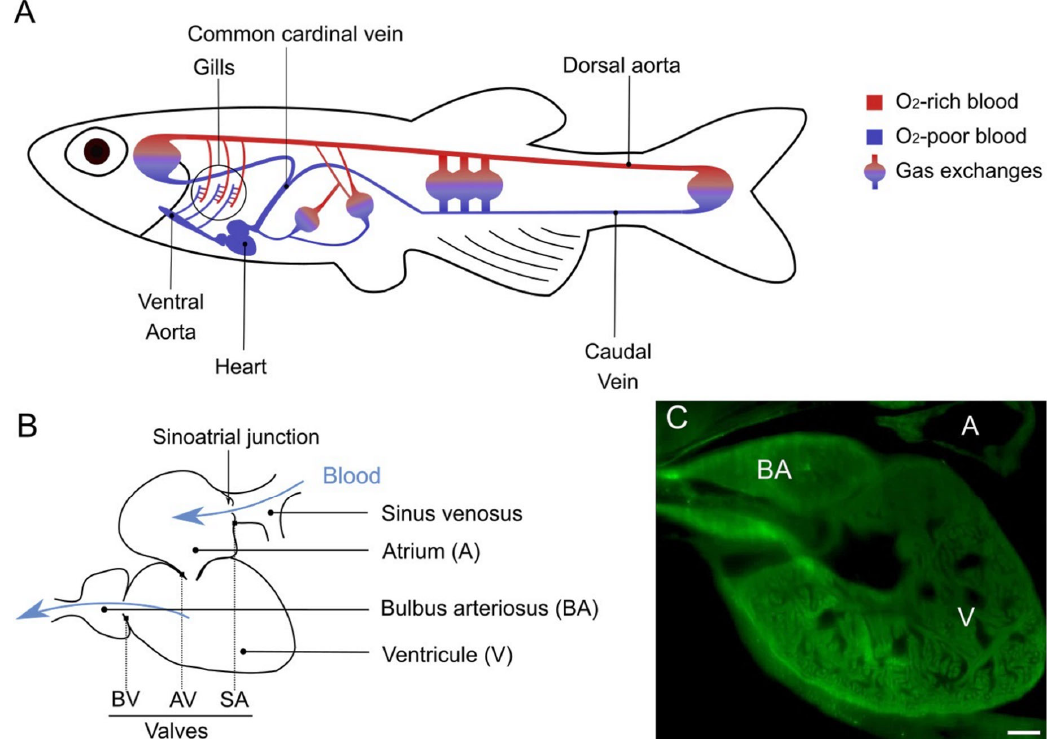
Figure 2. Zebrafish cardiovascular system. ( A ) Simplified illustration of the cardiovascular system of an adult zebrafish. The heart pumps deoxygenated blood to the ventral aorta, which distributes it to afferent branchial arteries, leading to gills (encircled). Once oxygenated, the blood is drained into efferent branchial arteries, to then be collected in the dorsal artery, which supplies the anterior and posterior parts of the fish. Exchanges are made in capillary beds and deoxygenated blood is returned to the heart for a new cycle. ( B ) Illustration of a zebrafish heart with its four cavities, the direction of blood is indicated by blue arrows; Valves are pointed with dotted lines; BV = bulboventricular; AV = atrioventricular; SA = Sinoatrial. ( C ) Image of an adult zebrafish heart obtained by light sheet microscopy (autofluorescence); the trabecular structure of the ventricle can be seen; Scale bar = 100 µ